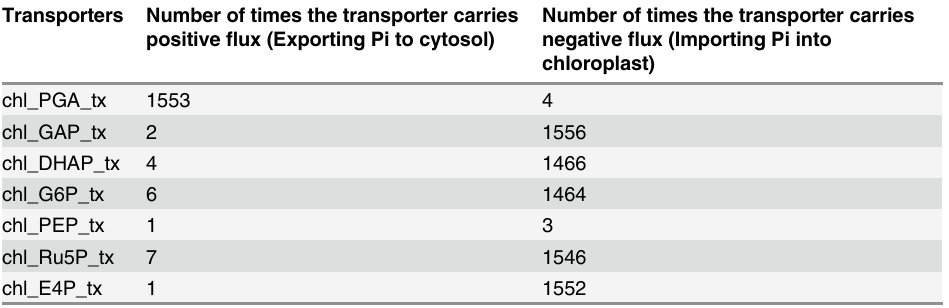
Table 3. Flux reversibility count for chloroplastic transports. It represents the thermodynamic possibility of inorganic phosphate exchange. Transporters Number of times the transporter carries Number of times the transporter carries positive fl ux (Exporting Pi to cytosol) negative fl ux (Importing Pi